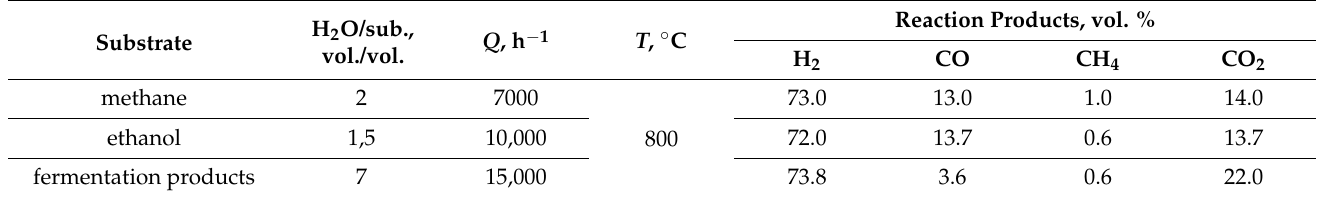
Table 12. Input and output parameters of the process of steam reforming of various organic substrates in a catalytic fuel gas generator for